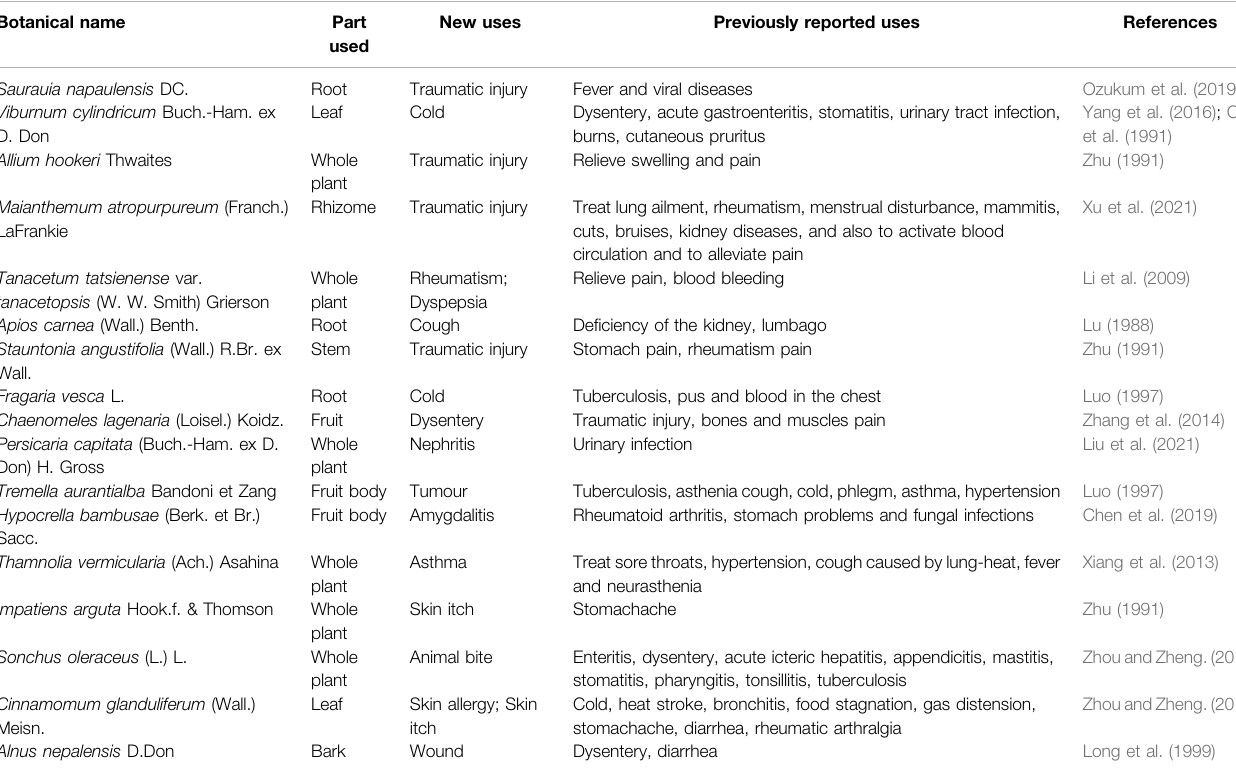
TABLE 5 | List of new therapeutic uses recorded in Dulongjiang area. Botanical